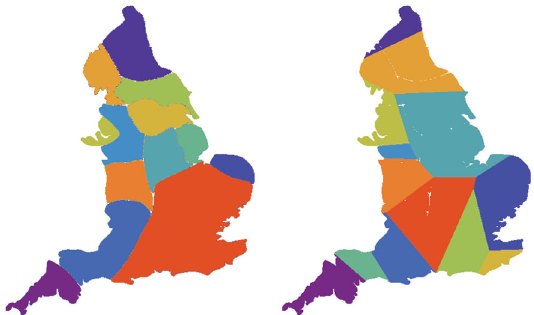
FIG. 8. Left map: Future England dialect boundaries predicted by Trudgill [4]. Right map: Voronoi tessellation with the same number of cells as Trudgill ’ s prediction. Colors determined by Hungarian